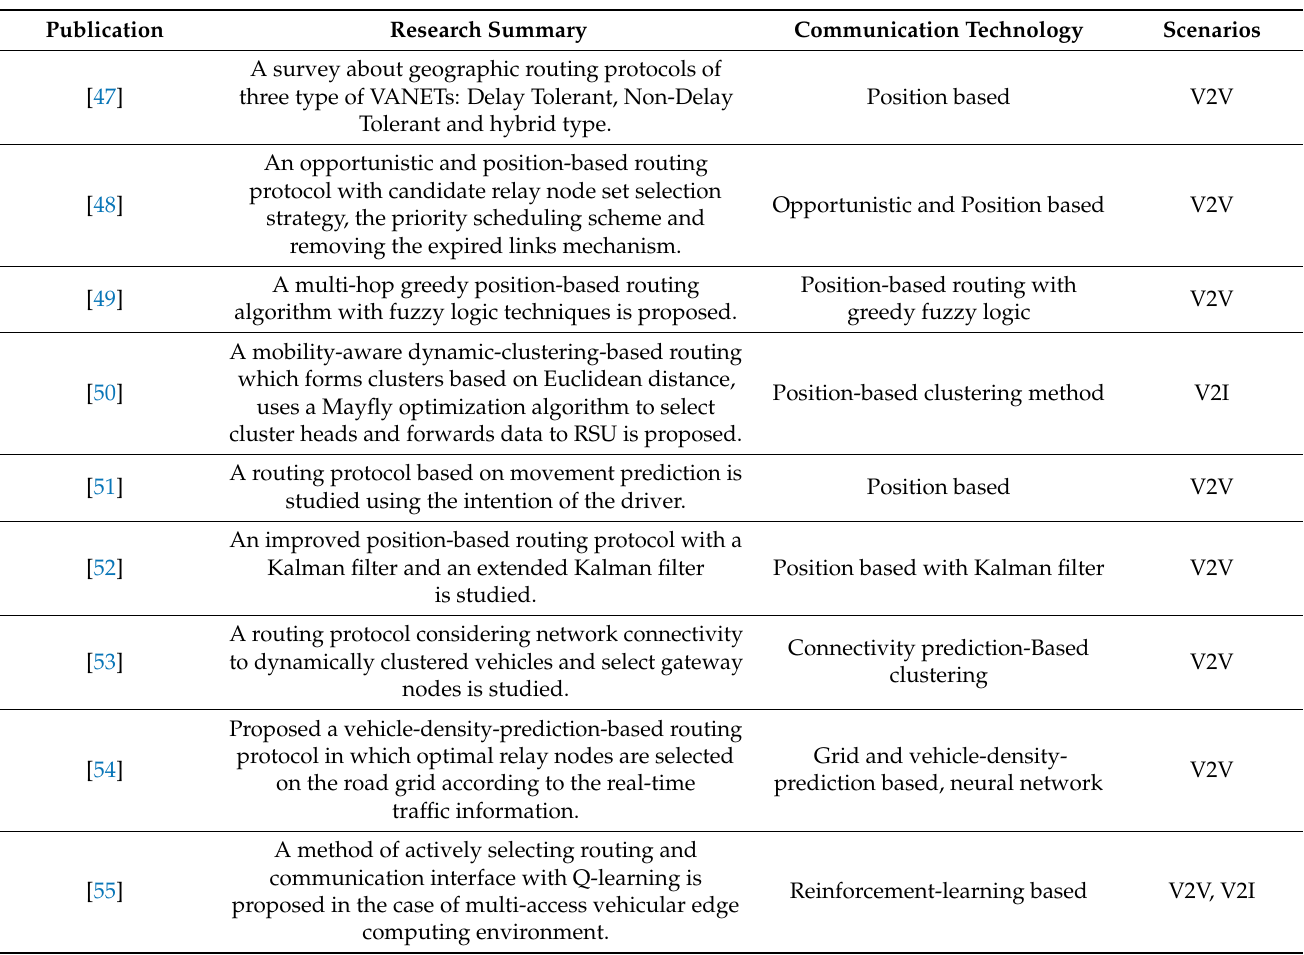
Table 2. Recent studies on Routing Protocol in